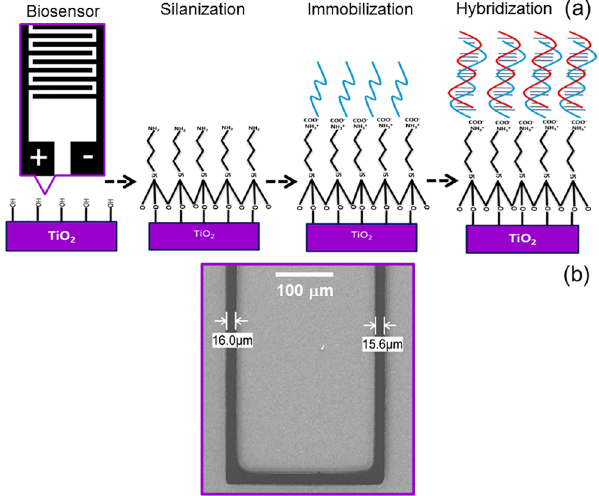
Fig 2. Preparation of sensing surface. (a) Schematics of the DNA immobilization and hybridization process. This resistive DNA biosensor with titanium dioxide nanoparticles enhances the current signal that eliminates PCR. (b) SEM image of interdigitated electrodes. The average gap size between two aluminum finger-shaped electrodes is 16 μ